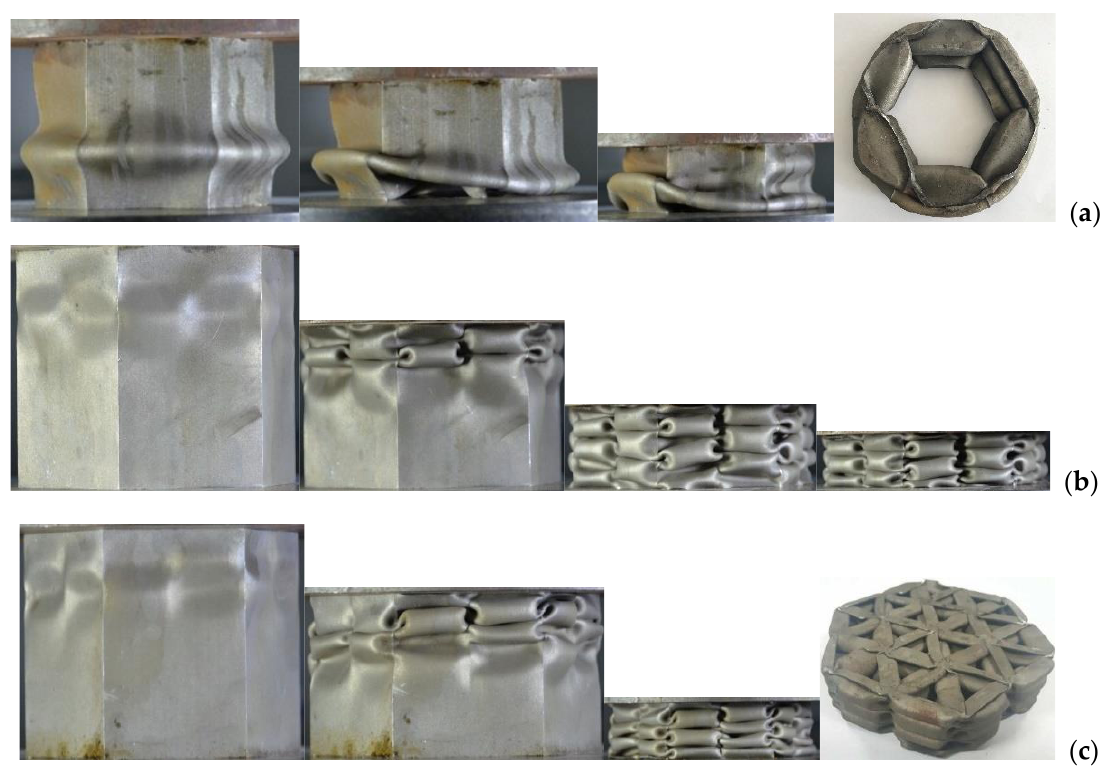
Figure 4. Crushing patterns of ( a ) hexagonal HST [19], ( b ) HMT-2a, and ( c ) HMT-2c.